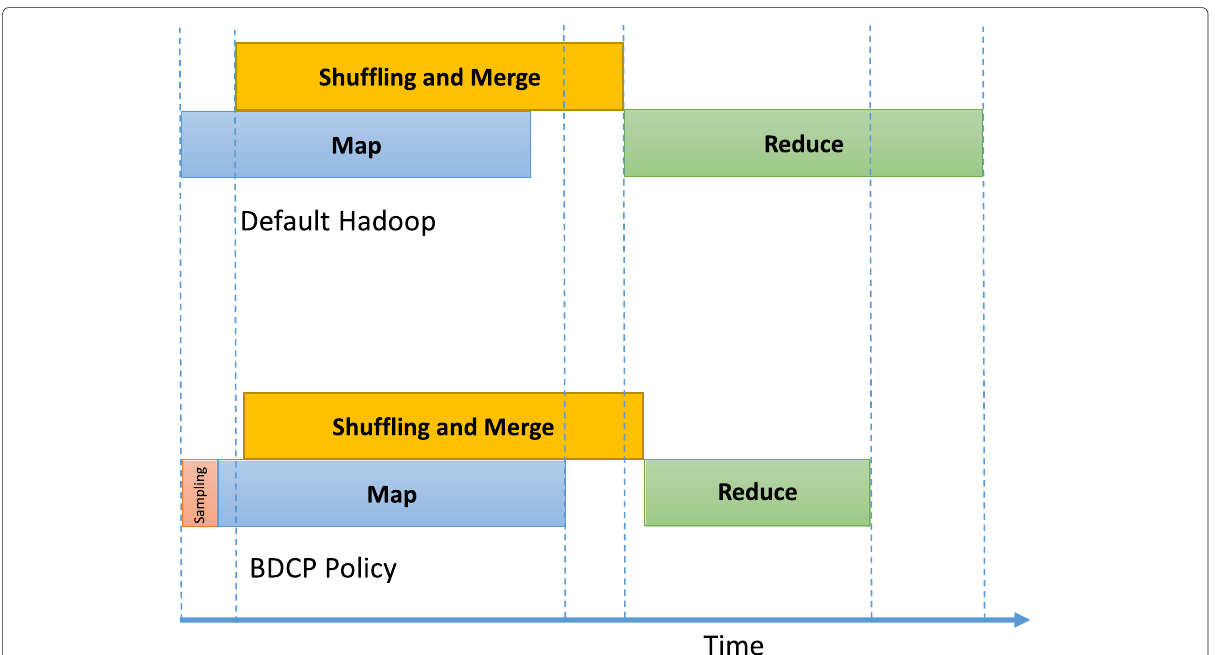
Fig. 6 MapReduce phases for Default Hadoop and